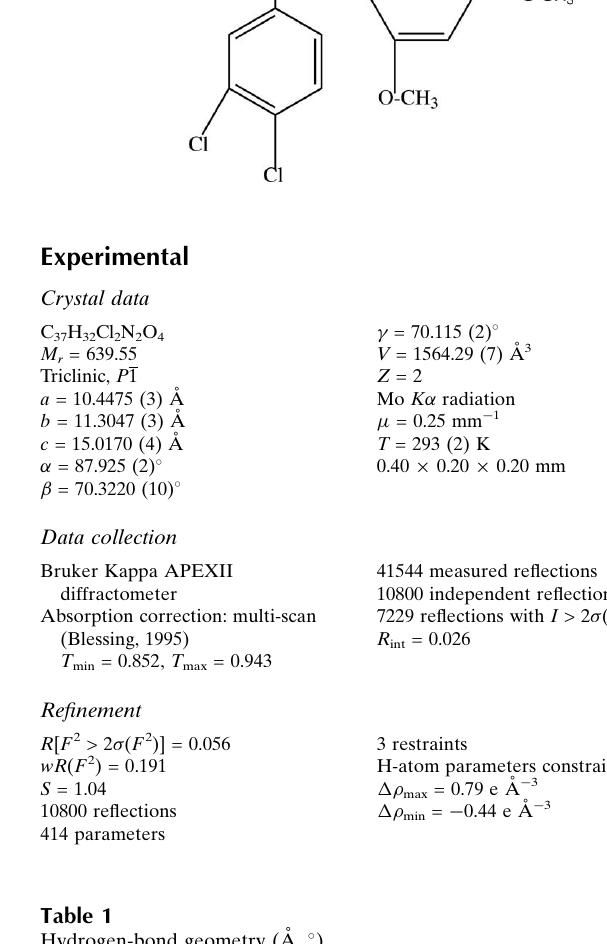
Hydrogen-bond geometry (A˚ , (cid:1)